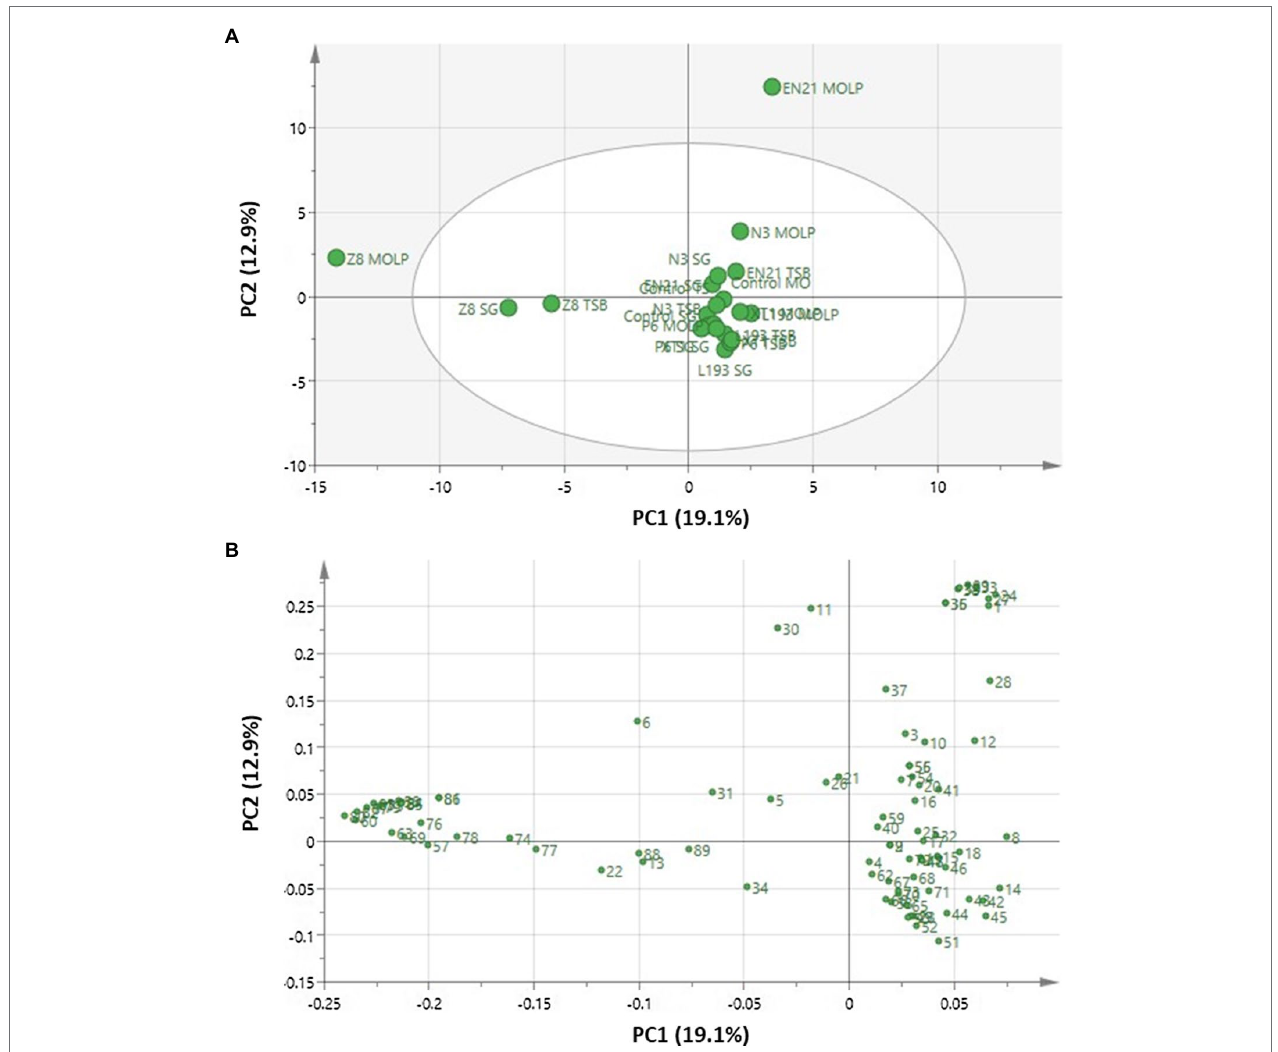
FIGURE 1 | Principal component analysis of volatile compounds obtained using HS-SPME and identified with the aid of GC/MS in B. atrophaeus L193 (L193), B. velezensis XT1 (XT1), Peribacillus sp. N3 (N3), P. segetis P6 (P6), S. equorum EN21 (EN21) and P. vulpis Z8 (Z8) grown in MOLP, SG and TSB media, as well as in uncultured control media. (A) Score plot. (B) Loading plot. Each volatile compound, which is assigned a reference number, can be seen in Supplementary Table S1